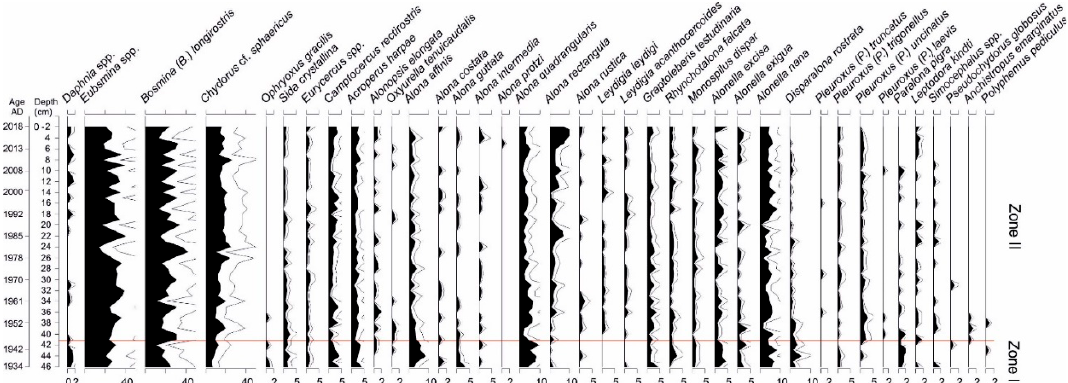
Figure 9. Relative abundance of the Cladocera species in Lake Sekšu.